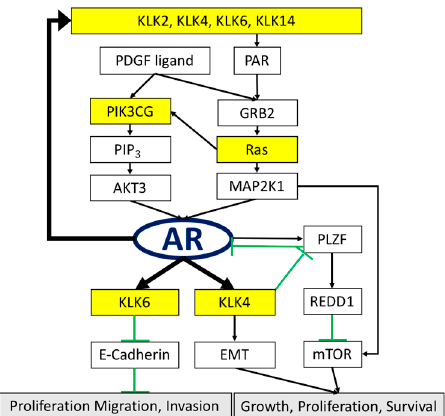
Figure 1. The schematic predicts the therapeutic efficacy of miR-378 silencing KLK genes in prostate cancer (PCa). The genes highlighted with a yellow background represent the gene sequences that partially complement miR-378 with at least 7 base pairs that sufficiently modulate their expression levels. The arrows represent promotion of the downstream gene activity, and the T sign (green) represents inhibition of their downstream genes. The AR gene might modulate the genes KLK2, KLK4, KLK6, and KLK14, and then feed back to itself through the PAR and the downstream RAS gene pathway.